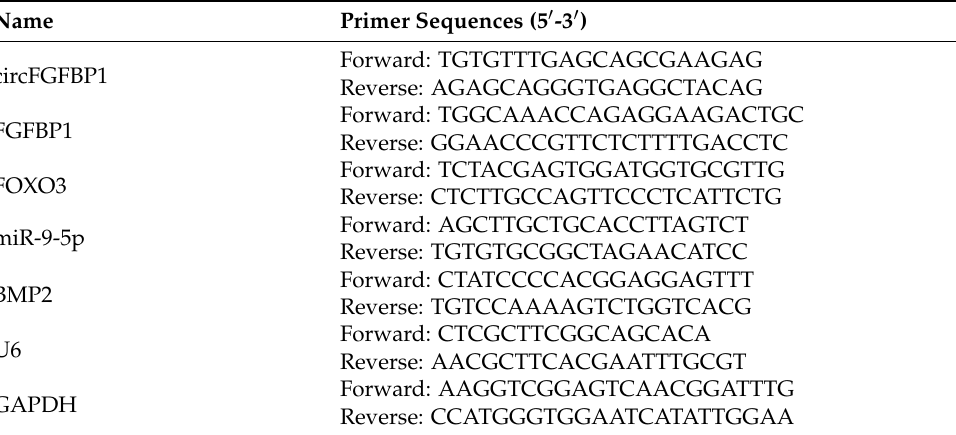
Table 2. The primer sequences used in this study for